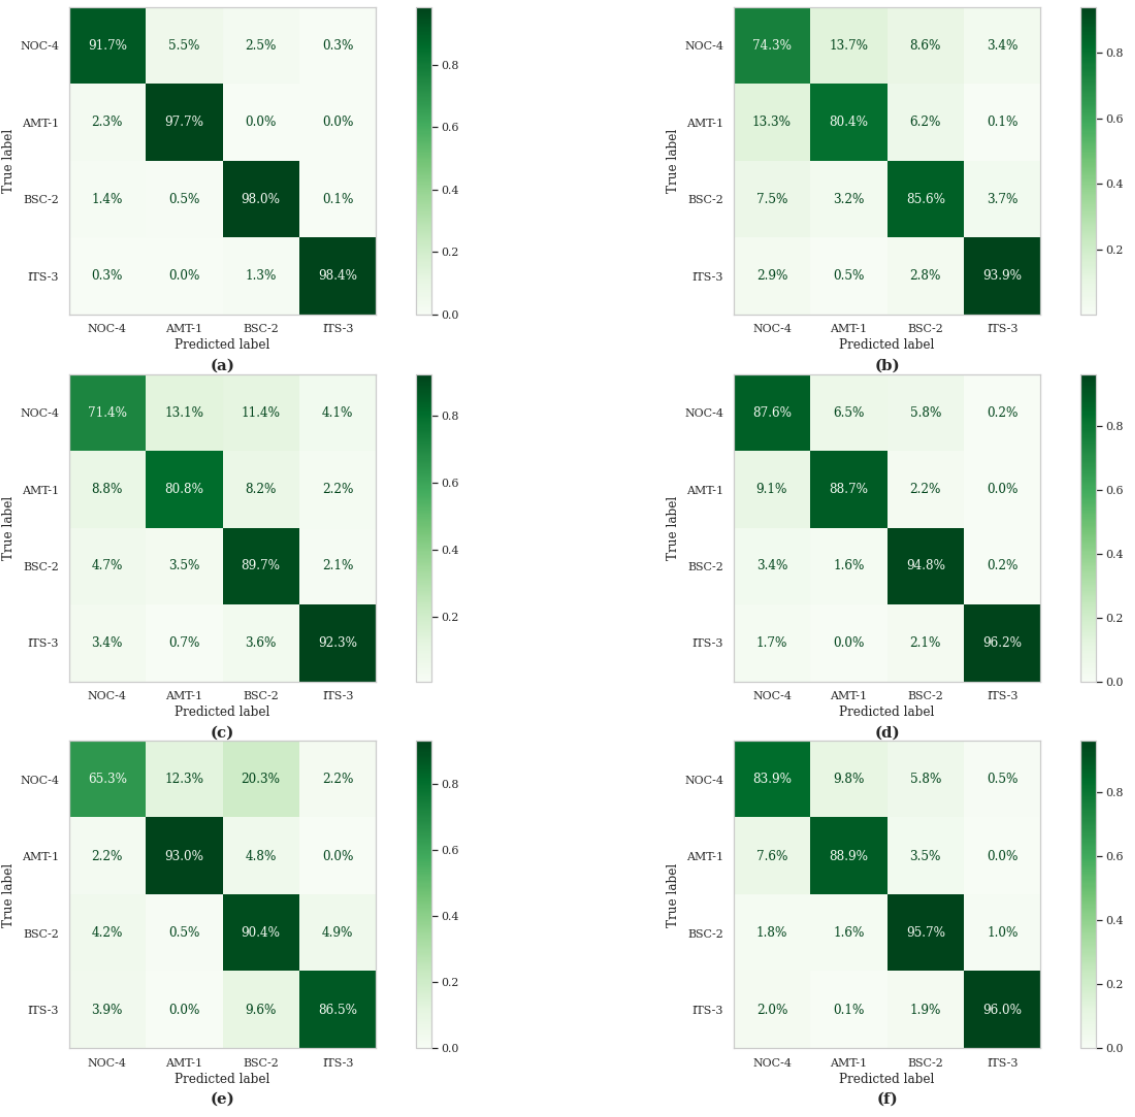
Figure 14. A full display of the confusion matrix of all ML classifiers on the datasets: ( a ) SVC, ( b ) DT, ( c ) RF, ( d ) kNN, ( e ) SGD, ( f )